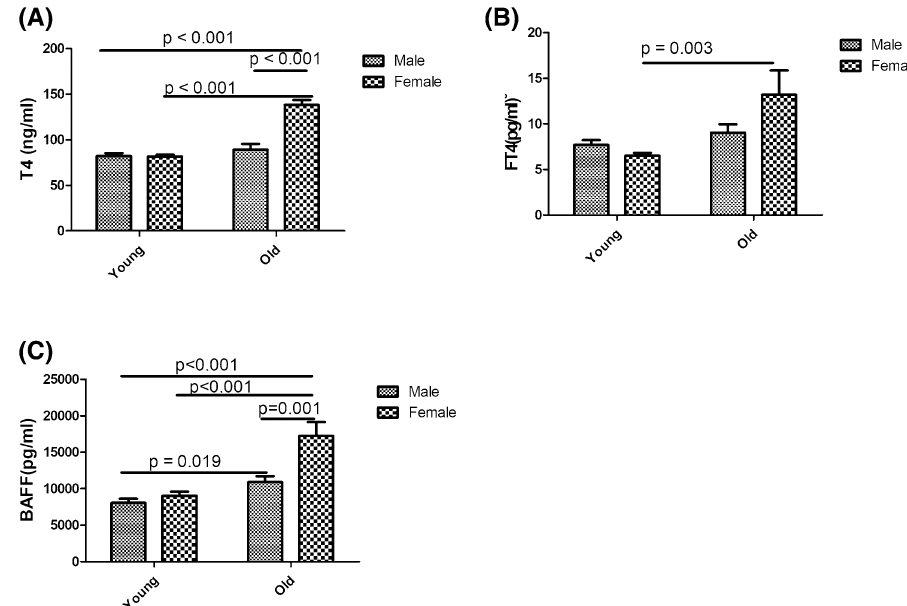
Figure 5. Total thyroxine (T4) ( A ), free thyroxine (FT4) ( B ), and B-cell-activating factor (BAFF) protein levels ( C ) among young male, young female, old male, and old female mouse groups. * p <